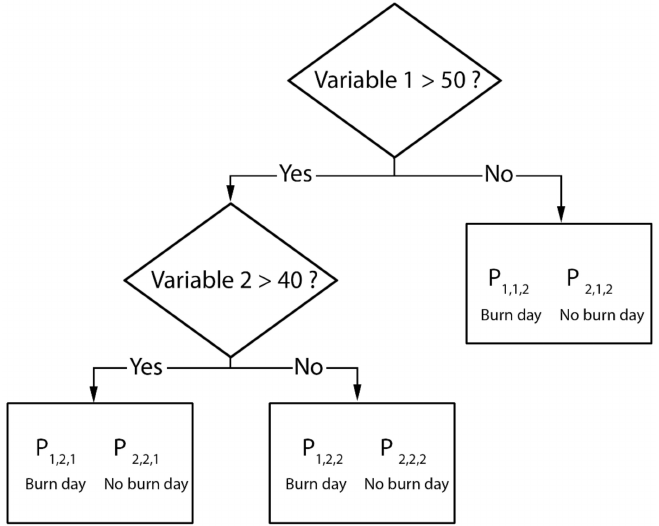
Figure A1. An example decision tree to generate the forecasting probabilities of each